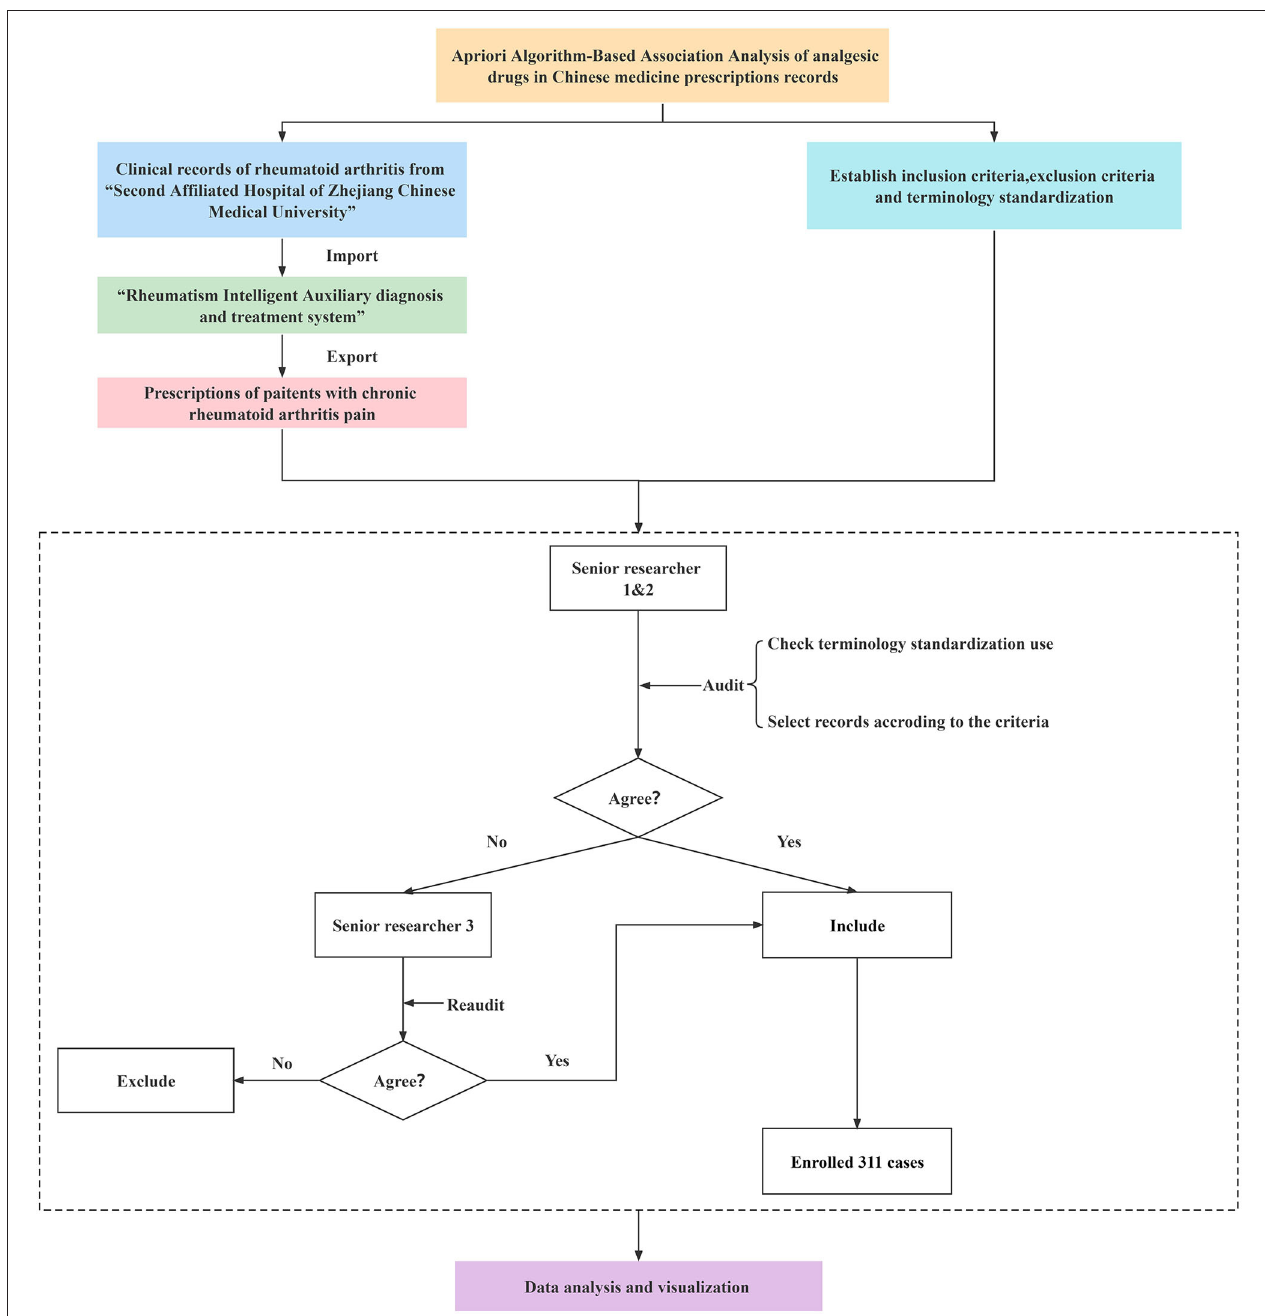
FIGURE 1 | Flow diagram of Apriori Algorithm-Based Association Analysis of analgesic drugs.